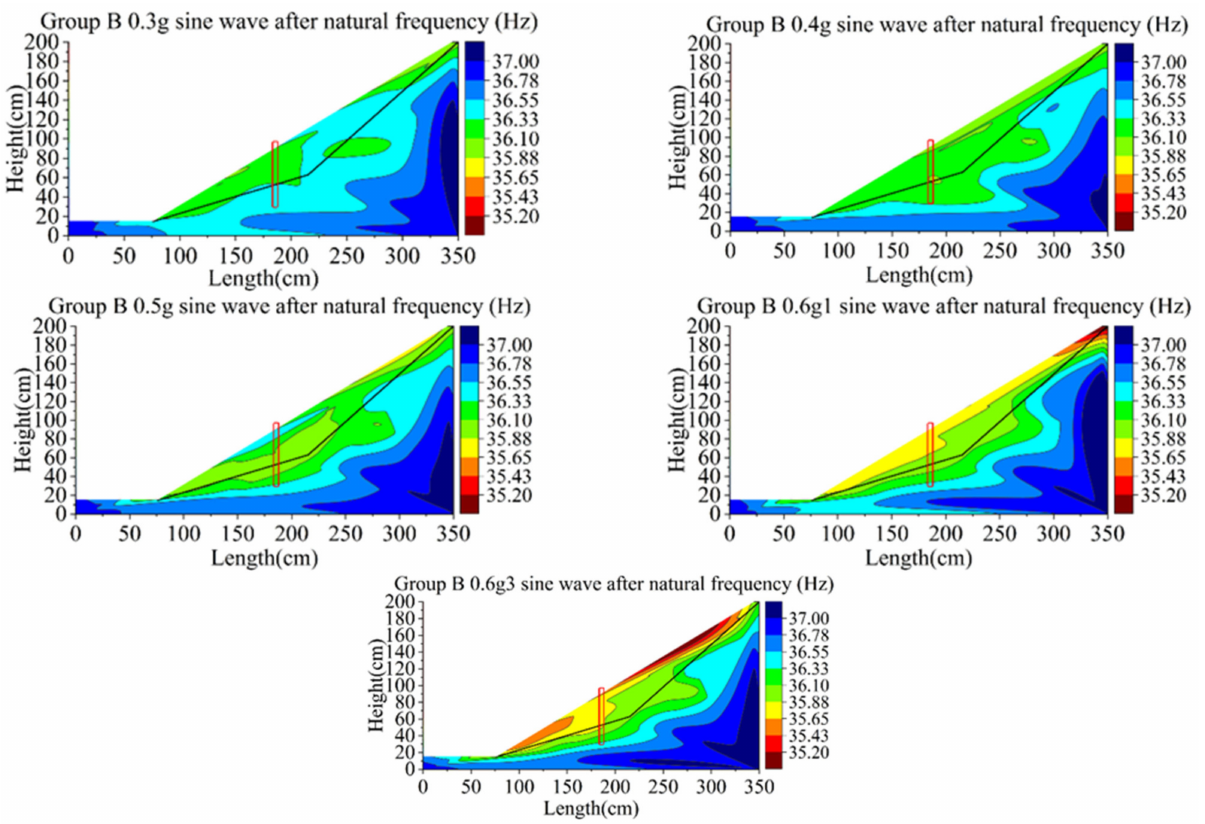
Figure 21. Contours of natural frequency of model